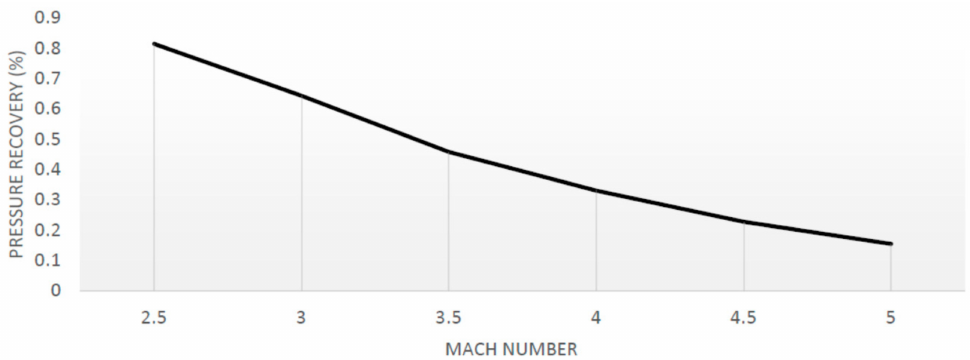
Figure 9. Pressure recovery vs. Mach number.